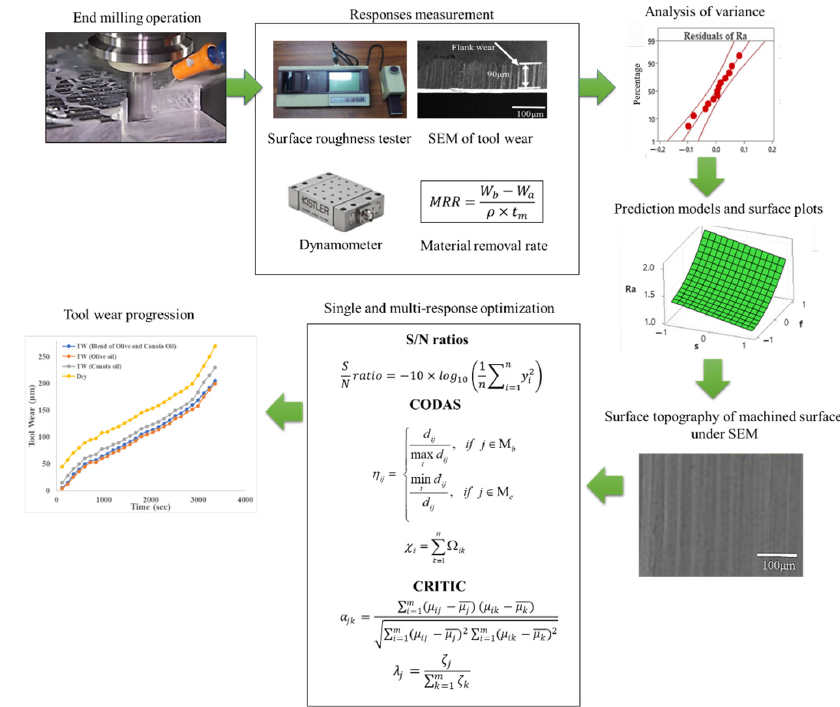
Figure 4. Graphical abstract of present study.